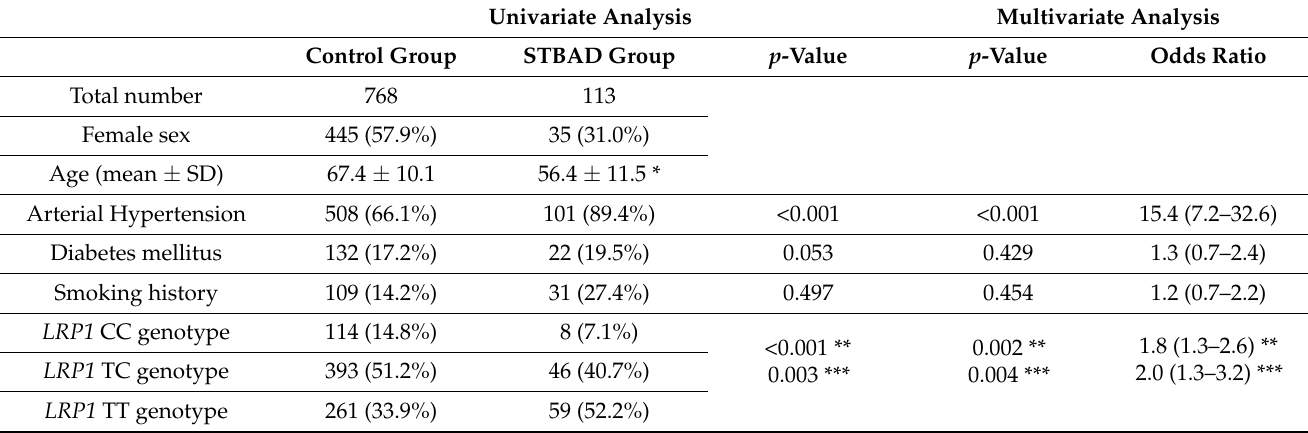
Table 1. Univariate analysis and multivariate logistic regression analysis adjusted for sex and age. Age and age at disease onset in years. Other parameters are given in total amount and percentage values. STBAD: Stanford type B aortic dissection; LRP1 : low-density lipoprotein receptor-related protein 1; SD: standard